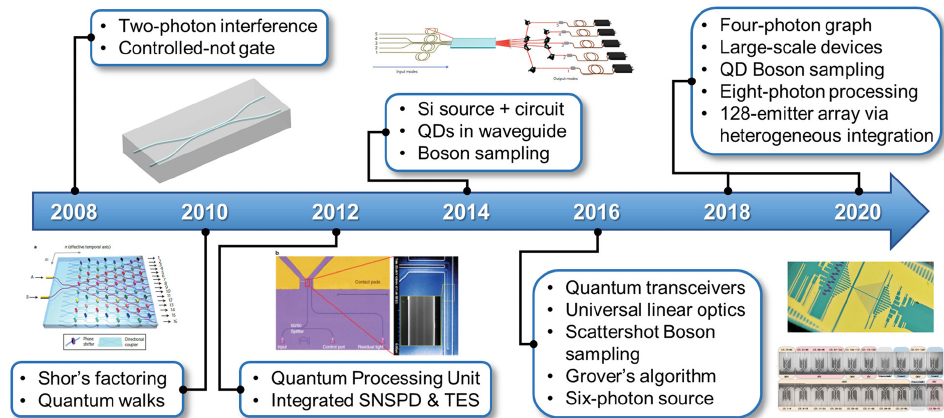
Figure 4. Key milestones for integrated quantum photonics in the past decade: on-chip two-photon interference and integrated controlled not (CNOT) gate [28].